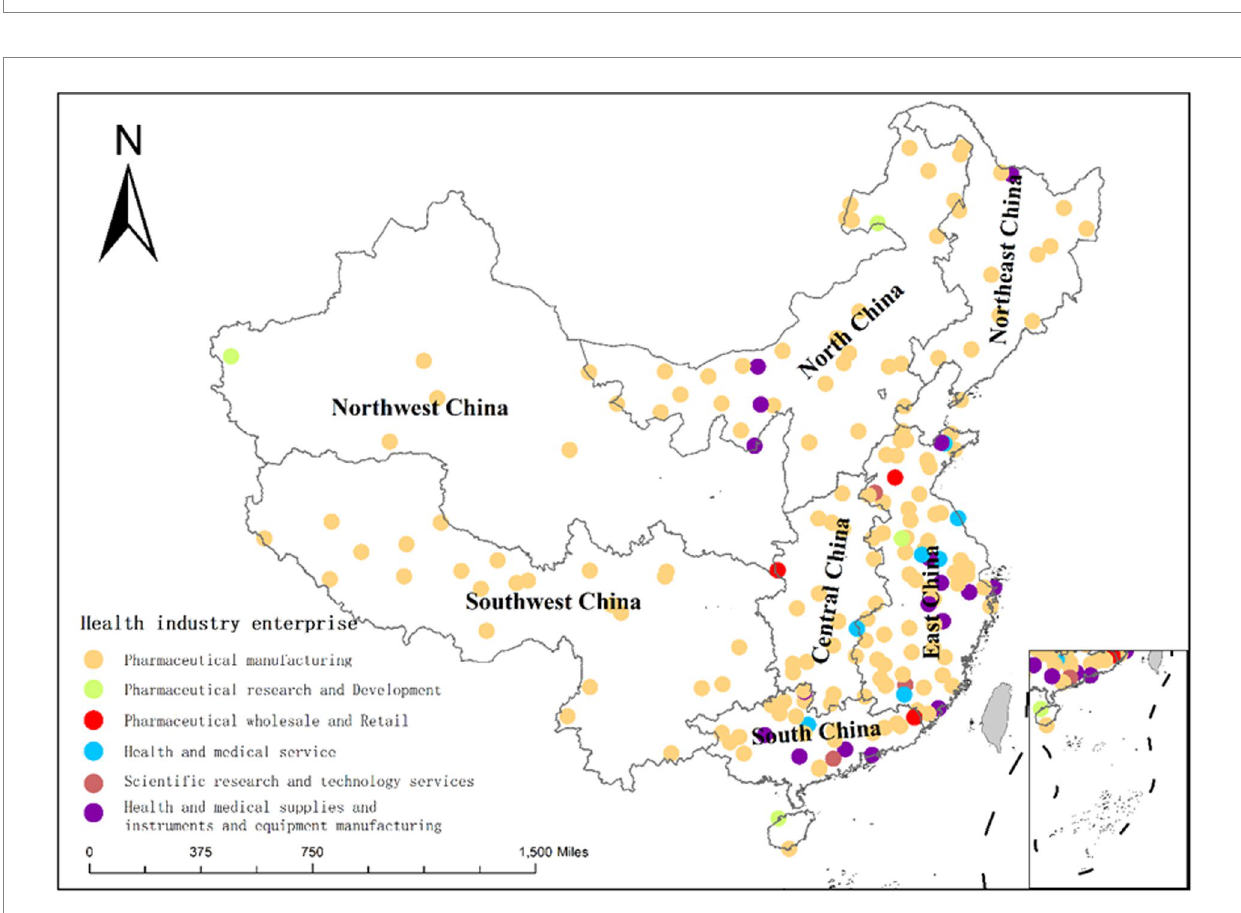
FIGURE 2 Distribution of the number of listed companies in the health industry by industry by